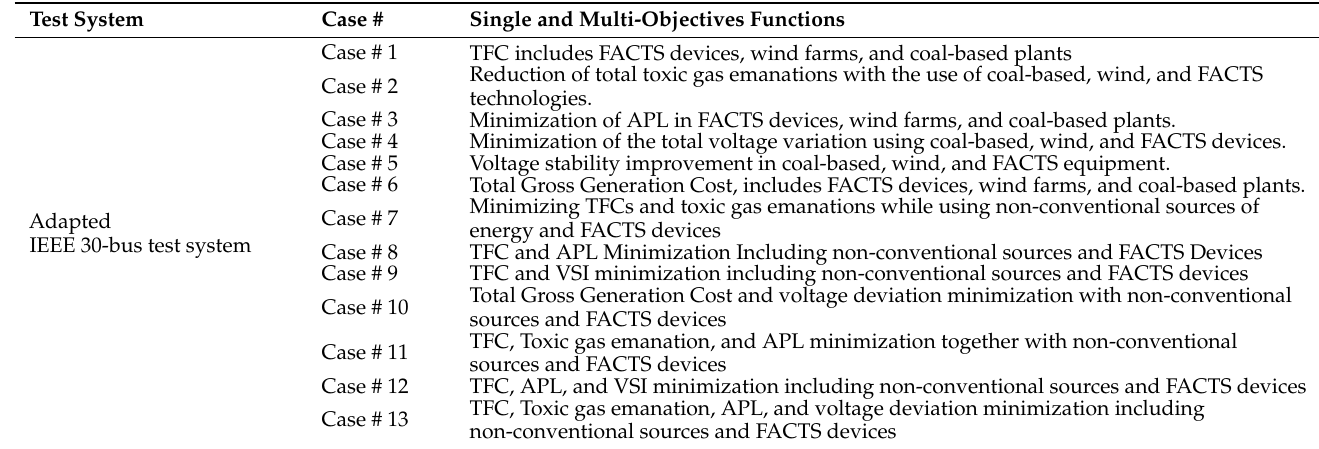
Table 8. Summary of case studies for adapted IEEE-30 bus test system.